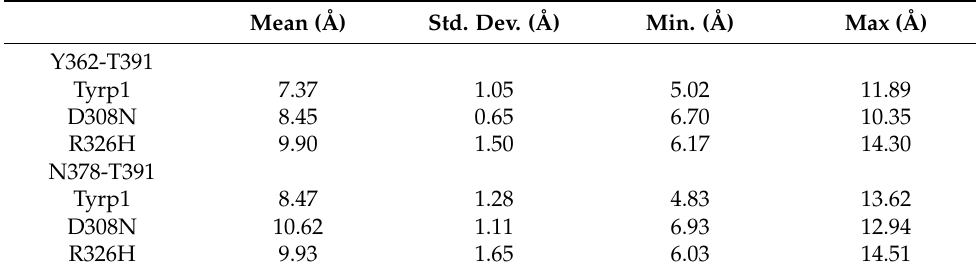
Figure 4. Compared region of residue-residue distance maps in Tyrp1 and C30R mutant. Homology models of Tyrp1 ( A ) and C30R ( B ) were equilibrated using MD in water for 100 ns. Residues in red indicate the intact and the broken (C30R) disulfide bridge. The residues in red and green indicate the focused region of the residue-residue distance maps in Figure 2. Table 2. Bottleneck distance